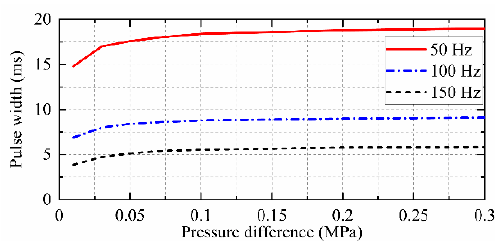
Figure 7. The maximum pulse width of three different PWM frequencies under different pressure difference.